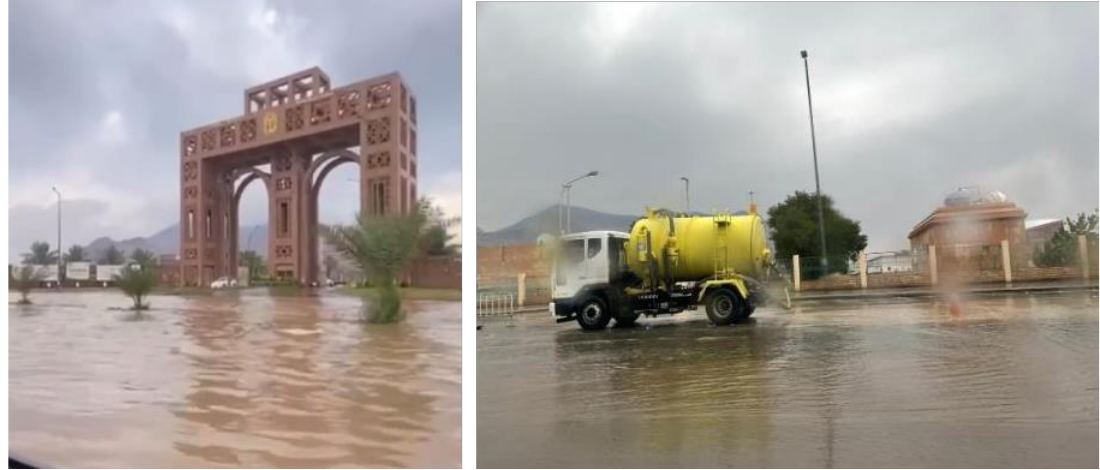
Figure 7. Rainfall accumulation during the storm on 3 January 2023.